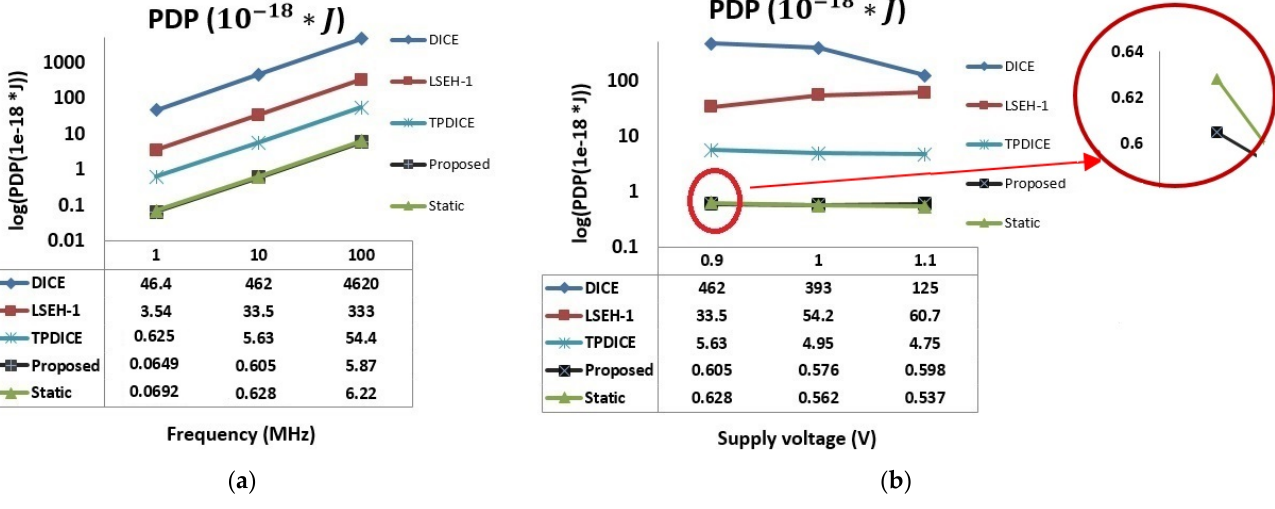
Figure 9. PDP of various D-latches: ( a ) at various frequencies from 1 MHz to 100 MHz and 0.9 V power supply voltage; ( b ) at three supply voltages and 10 MHz input frequency.